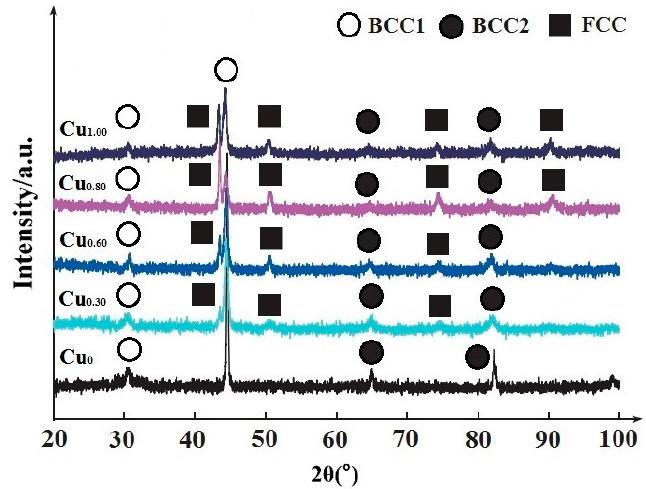
Figure 2. XRD pattern of high-entropy alloy.